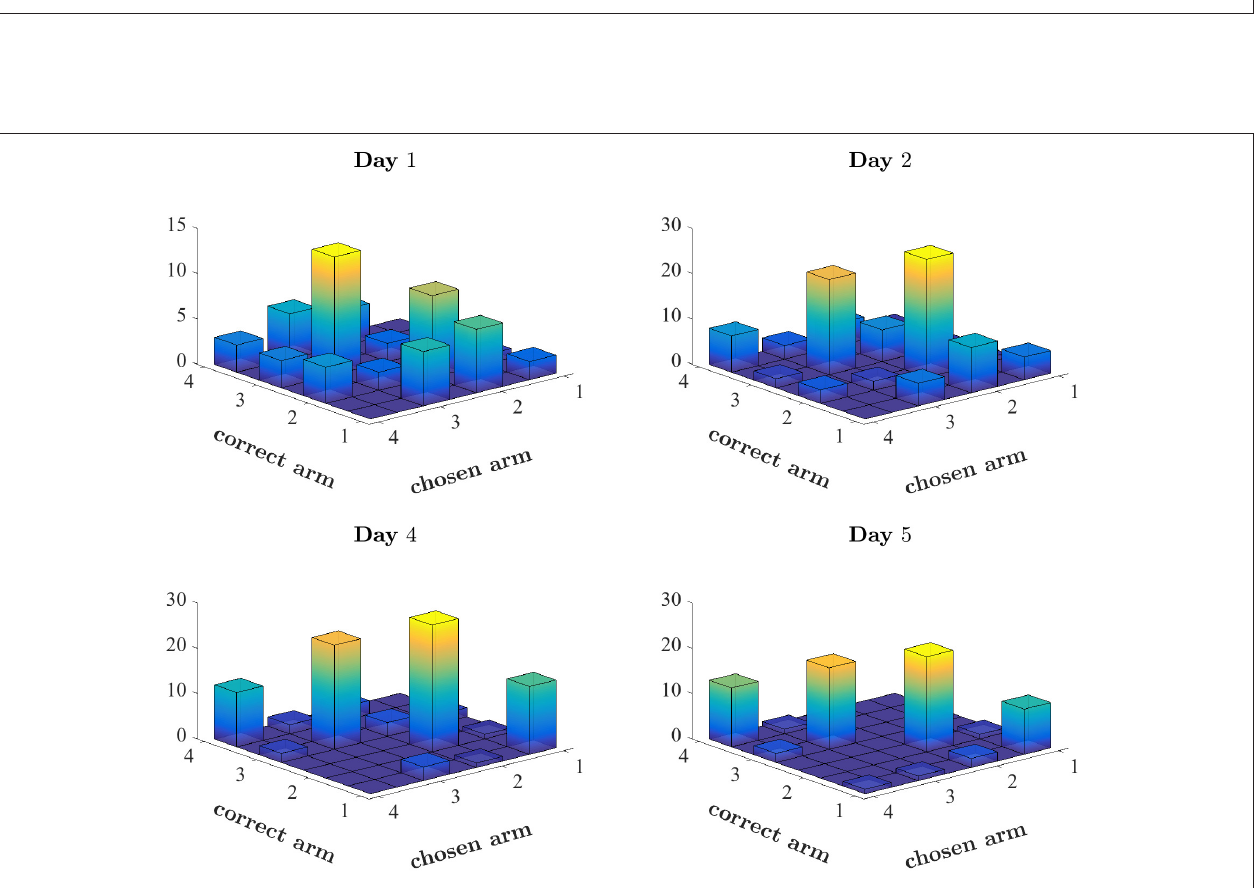
FIGURE 2 | Animals’ performance throughout training: percent of correctly performed trials, by day. Vertical lines depict set shifts. The identities of the set in each phase is indicated below. The horizontal line depicts chance level performance. Only days with at least half of the rats are presented. Mean and median success rate in each day are depicted by a black square and horizontal line, respectively. Bars represent the 25 and 75th percentiles correspondingly. (A) The odor-first group, n = 8. (B) The LED-first group, n = 10.